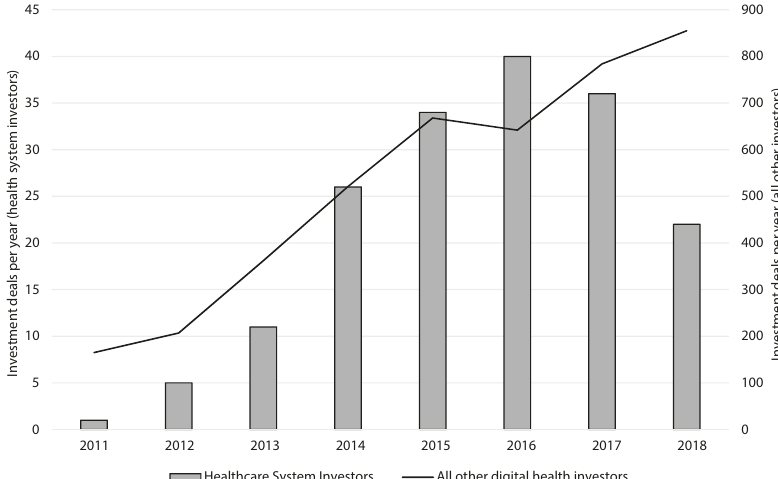
Fig. 1 Yearly volume of digital health investment deals by health systems. Number of digital health investments per year by health system investors and all other investors.